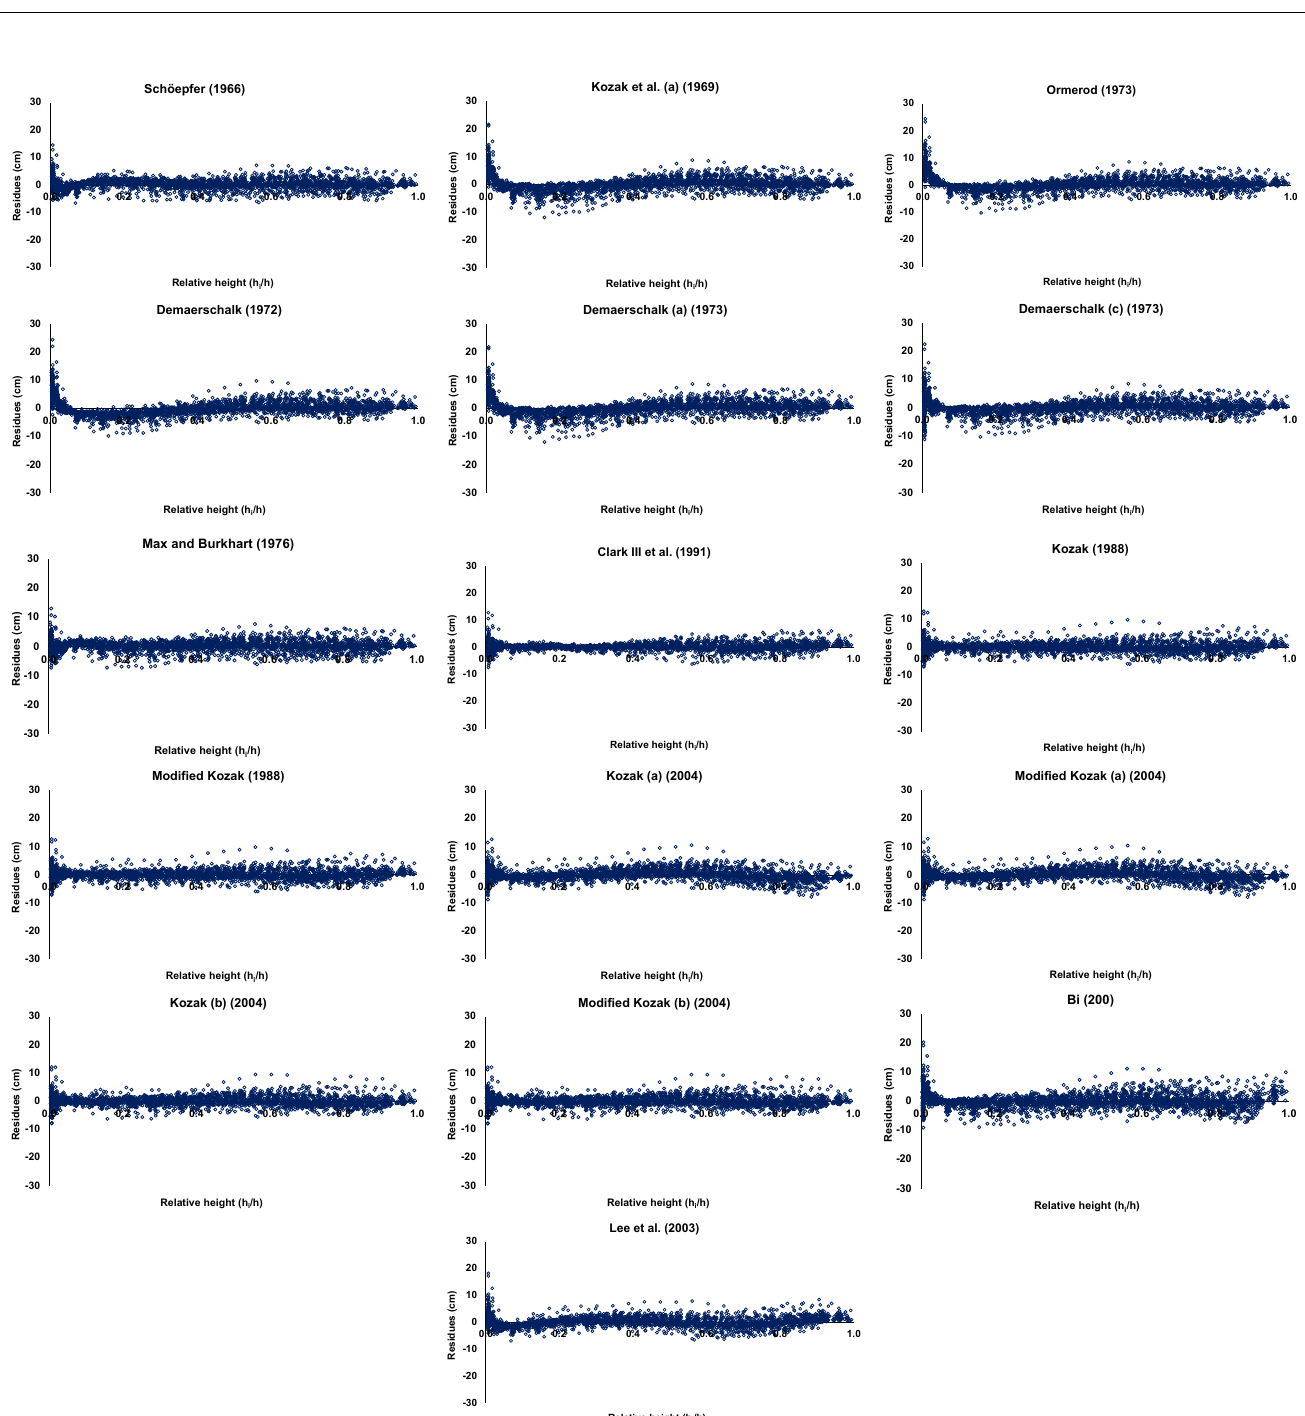
Figure 3. Residues from the estimates of diameters in the function of the relative height ( h i /h ) when using the taper equations without stratification of Tectona grandis L.f. data., central − west region, Brazil [25,28,30–32,36,40,42–44,47].